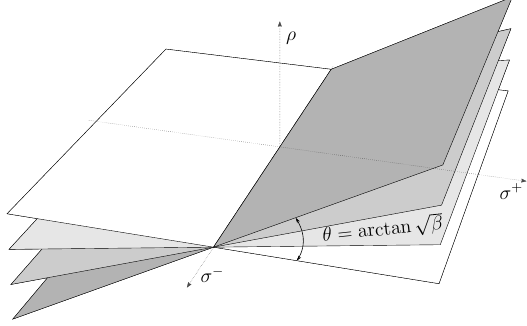
Figure 1 . Increasing (cid:12) corresponds to increasing the angle (cid:18) of the metric plane with respect to the (cid:27) + (cid:27) (cid:0) ( (cid:12) = 0) plane. The (cid:12) ! 1 limit corresponds to the (cid:27) + = 0 plane. coordinates, (cid:27) (cid:6) = (cid:28) (cid:6) (cid:27) , as ds 2 = (cid:0) d(cid:27) + d(cid:27) (cid:0) + (cid:12) ( d(cid:27) + ) 2 . In order to picture this, it is useful to consider a three-dimensional (cid:13)at space with line element ds 2 = (cid:0) d(cid:27) + d(cid:27) (cid:0) + d(cid:26) 2 p subjected to the constraint (cid:26) = (cid:12)(cid:27) + . The intrinsic two-dimensional metric is then given p by equation (2.6) and corresponds to a plane inclined by an angle (cid:18) = arctan (cid:12) with respect to (cid:26) = 0. See (cid:12)gure